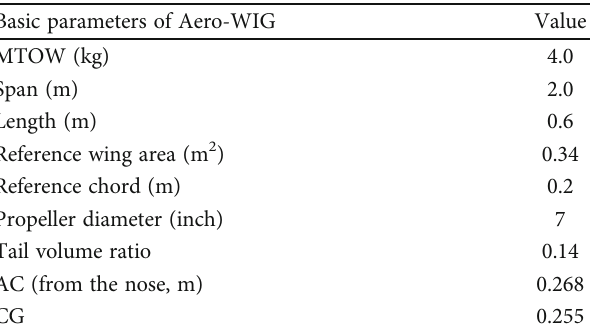
Table 1: Basic parameters of